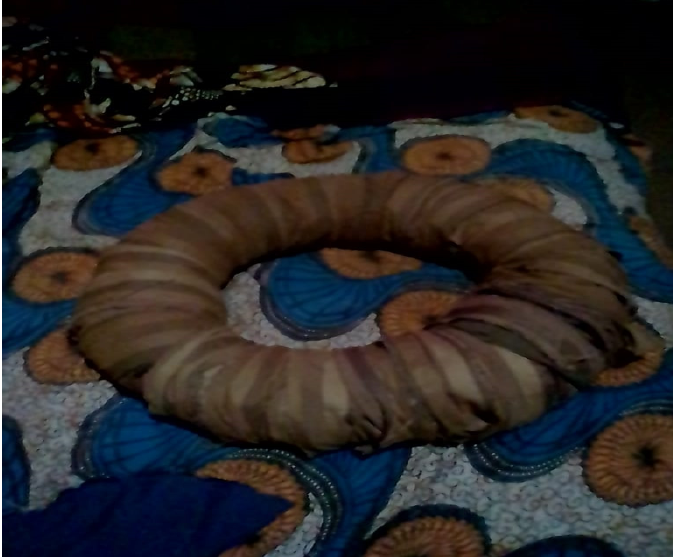
Figure 3. An example of a cloth wreathe that was used to limit the flow of urine. Picture taken with patient’s consent.